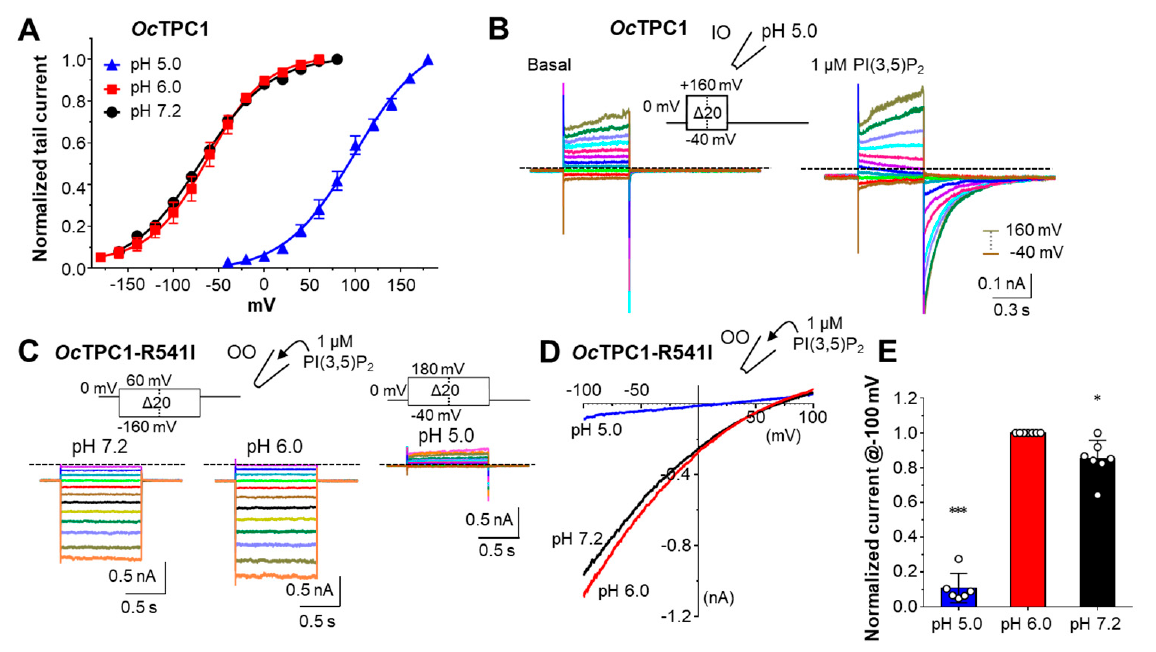
Figure 6. Low pH inhibits rabbit TPC1 in both voltage-dependent and -independent manners. HEK293 cells were transiently transfected with cDNA coding for Oc TPC1-EGFP or Oc TPC1-R540I- EGFP. ( A ) G–V curves of Oc TPC1 in inside-out (IO) patches with pipette solutions having pH 7.2, pH 6.0, or pH 5.0 and exposed to 1 µ M PI(3,5)P 2 in the bath. Data points are means ± SEM of n = 4 (pH 7.2, same data from Figure 5F) and n = 5 (pH 6.0 and pH 5.0) patches fit by Boltzmann function. ( B ) Representative currents elicited by voltage steps from − 40 mV to +160 mV with 20-mV increments (see inset) in an IO patch excised from a cell that expressed wild-type Oc TPC1. The pipette solution had pH 5.0 and the patch was unstimulated ( left ) or exposed to 1 µ M PI(3,5)P 2 ( right ). ( C ) Representative currents elicited by voltage steps from − 160 mV to +60 mV with 20-mV increments ( left and middle , see inset) and from − 40 mV to +180 mV with 20-mV increments ( right , see inset) in an outside-out (OO) patch excised from a cell that expressed Oc TPC1-R540I. The pipette solution contained 1 µ M PI(3,5)P 2 and the patch was exposed sequentially to pH 7.2 ( left ), pH 6.0 ( middle ), and pH 5.0 ( right ) bath solutions. For both ( B , C ), holding potential was 0 mV and horizontal dashed lines indicate zero current. ( D ) Representative I–V curves derived from voltage ramps for Oc TPC1-R540I in an OO patch with the pipette solution containing 1 µ M PI(3,5)P 2 and exposed sequentially to pH 7.2 ( black ), pH 6.0 ( red ), and pH 5.0 ( blue ) bath solutions. ( E ) Summary of currents at − 100 mV recorded as in ( D ), normalized to that at pH 6.0. Data are means ± SEM for n = 6–7 patches. White circles represent individual data points. * p < 0.05, *** p < 0.001, different from the theoretical mean of 1 by one-sample t -test.